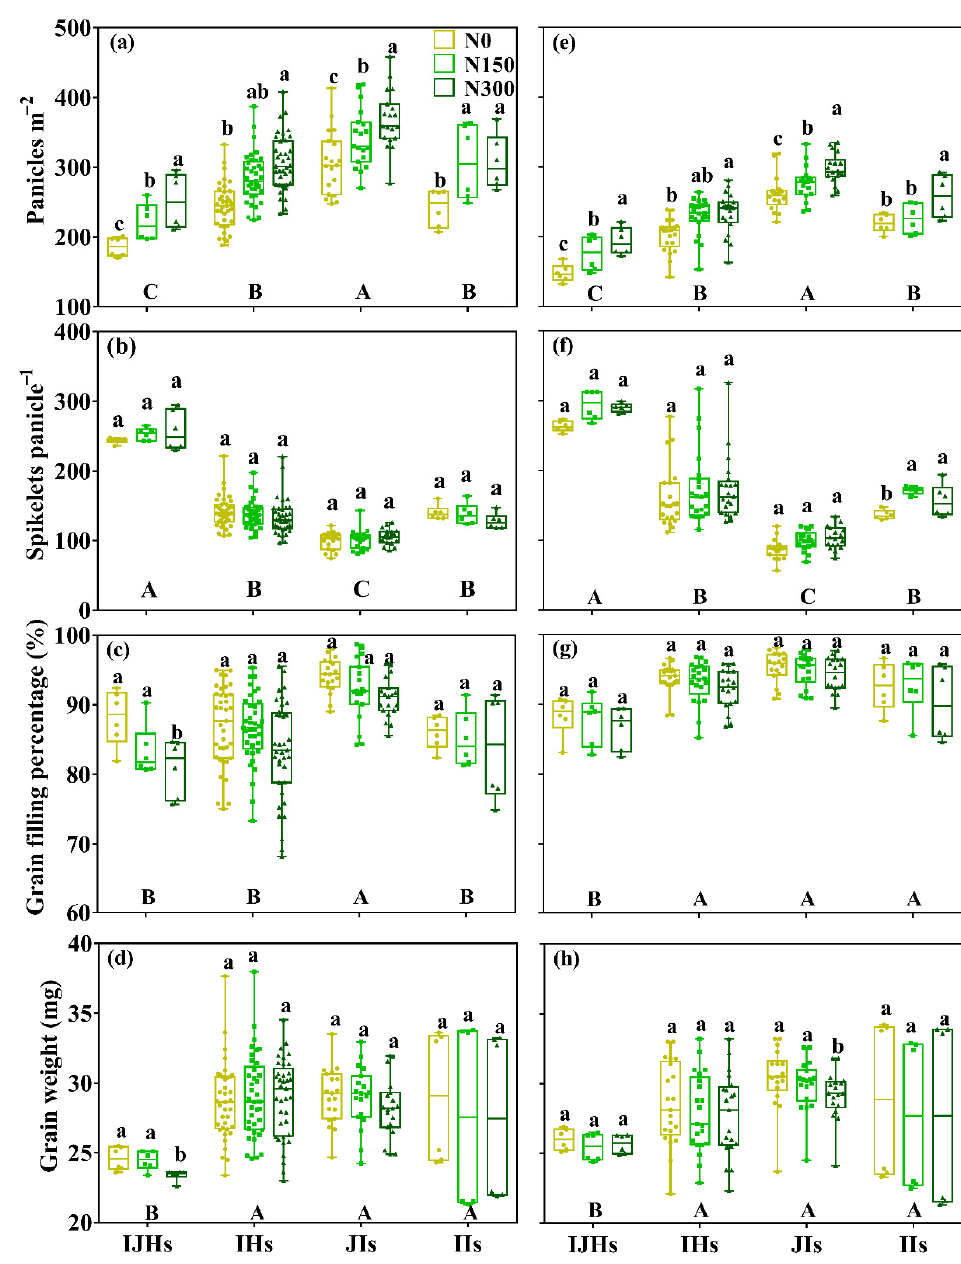
Figure 3. Boxplots of yield components for indica-japonica hybrids (IJHs), indica hybrids (IHs), japonica inbreds (JIs), and indica inbreds (IIs) under different N levels in 2017 ( a – d ) and 2018 ( e – h ), respectively. Data are means of three replicates. Different uppercase letters above columns indicate statistical significance at the p < 0.05 level among different rice groups, and different lowercase letters above columns indicate statistical significance at the p < 0.05 level among different nitrogen levels.